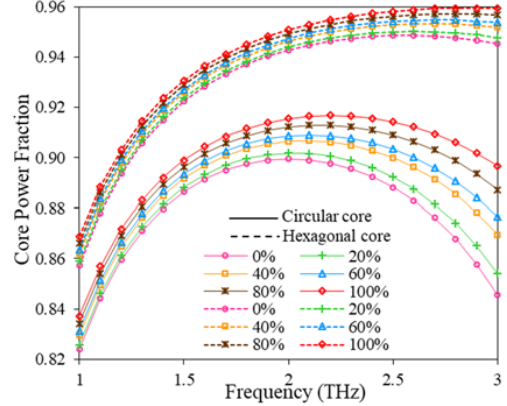
Figure 3. Core power fraction for hexagonal and circular core with the change of frequency.